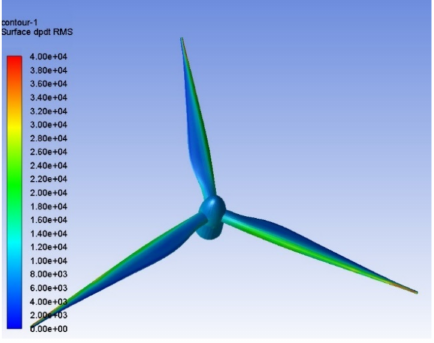
Figure 5. Pressure pulsation on the surfaces of the blades (kPa).